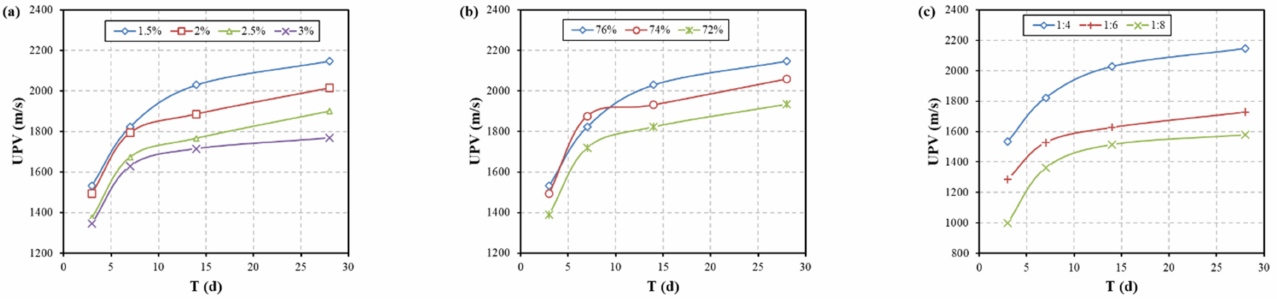
Figure 12. Effects of ( a ) FC, ( b ) SC and ( c ) CTR on the UPV of FCPB.